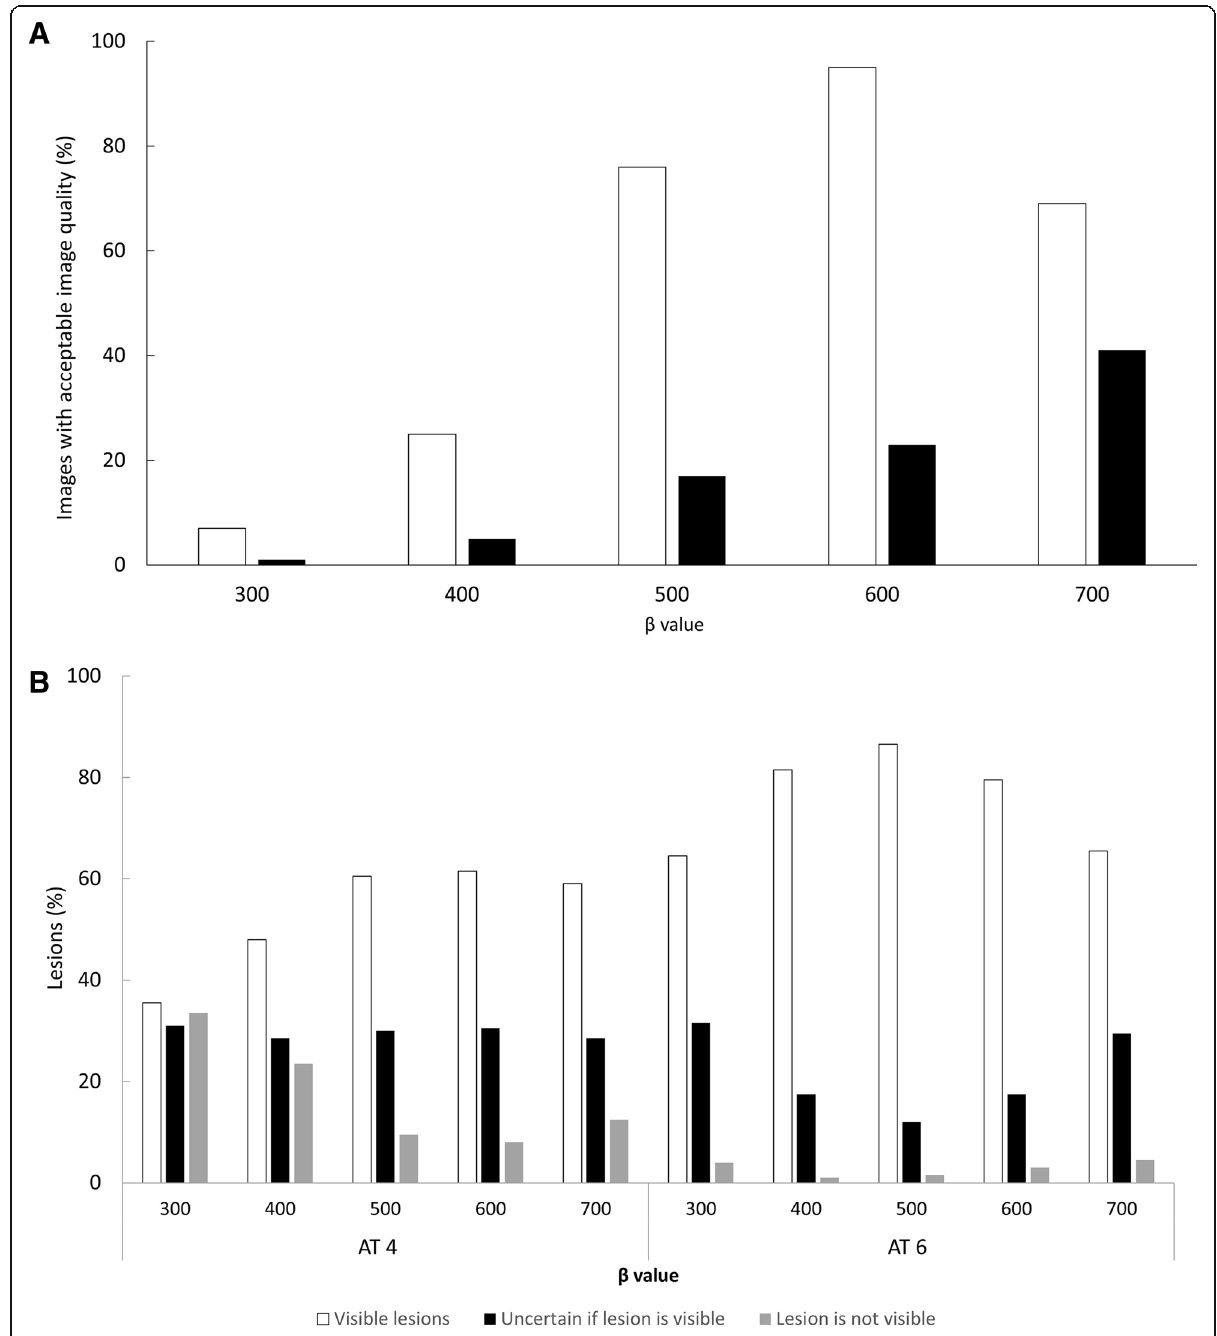
Fig. 3 Image quality ( a ) and lesion detectability ( b ) for the combinations of AT (min/bed × MBq/kg) and β